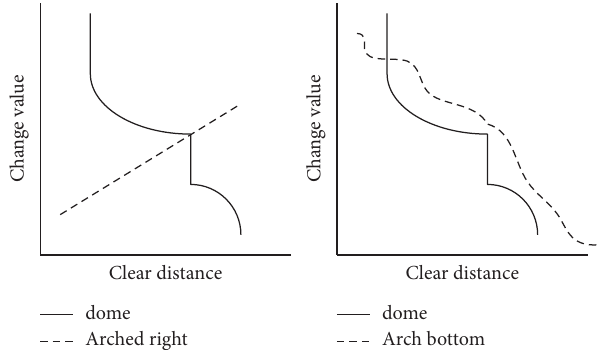
Figure 10: Te trend diagram of the lining displacement value of the left-line